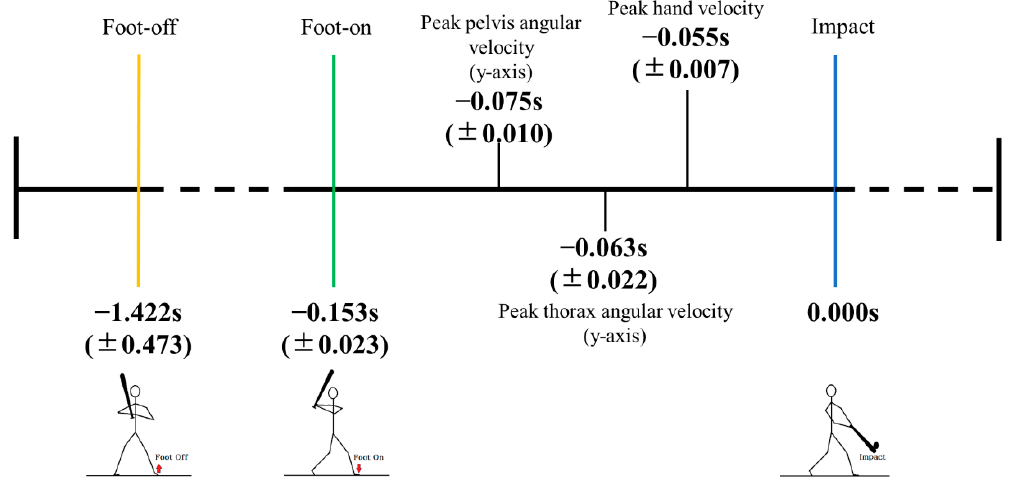
Figure 6. Mean timing (standard deviation) of segmental peak velocities and key events during baseball swing.